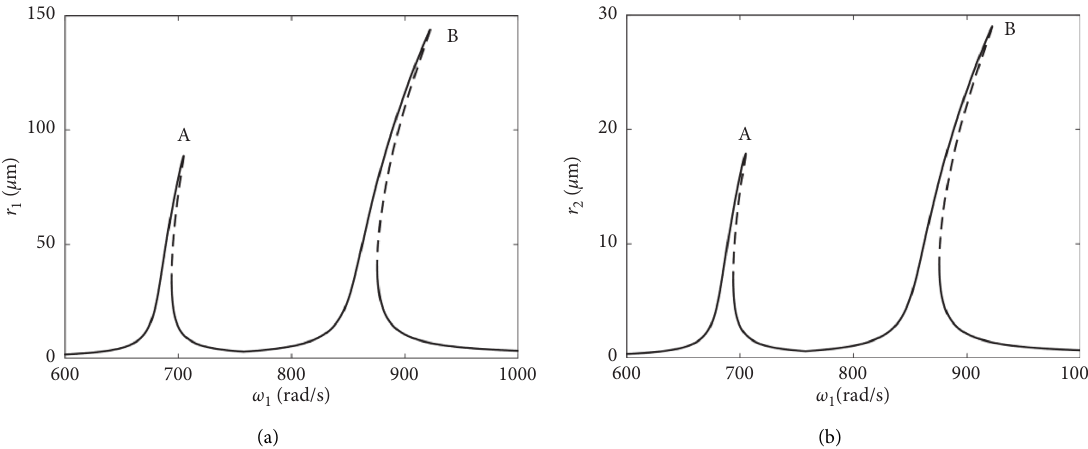
Figure 7: Amplitude frequency curves for the bifurcation mode of the region III in Figure 4 ( k the LP rotor. (b) For the HP rotor. Solid lines represent stable solutions, and dotted lines represent unstable solutions.